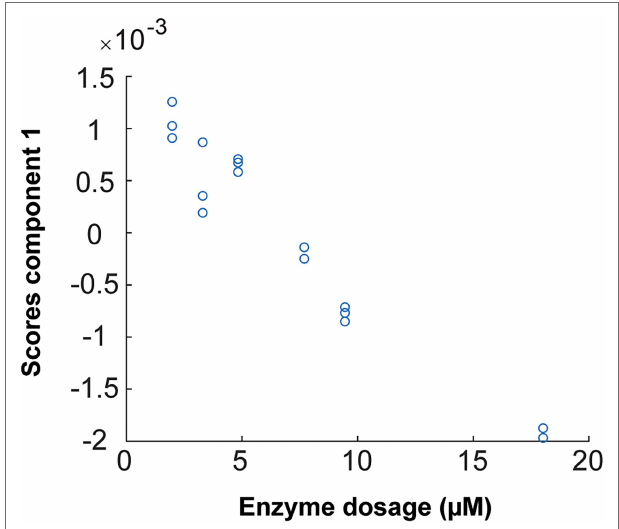
FIGURE 12 | PARAFAC first component scores versus enzyme dosage plotted to build calibrations for Fhf2 Δ 484 on F. evanescens . The straight line, with the equation of Y = − 0.0002 X + 0.0015, was fitted with the data. R 2 = 0.95. Due to sign ambiguity in component analysis, the sign of the slope of the fitted calibration is not linked to substrate or product